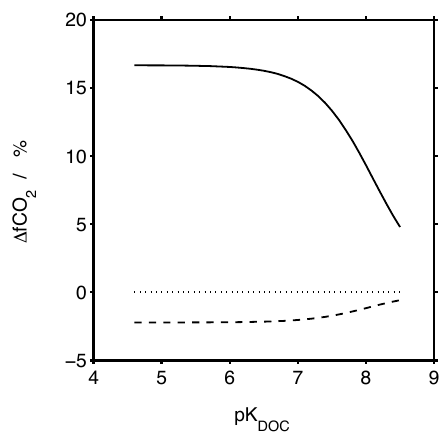
Fig. 6. 1f CO 2 (A (solid line), 1f CO 2 (A (dashed line), T ,C T ) T , pH ) and 1f CO 2 (C (dotted lines) as a function of the choice of the T , pH ) pK of the organic acid/base system. We assume a potential DOM- alkalinity of 50µmolkg − 1 , a true f CO 2 of 400µatm, and standard conditions as explained in the text (Sect. 3.2).